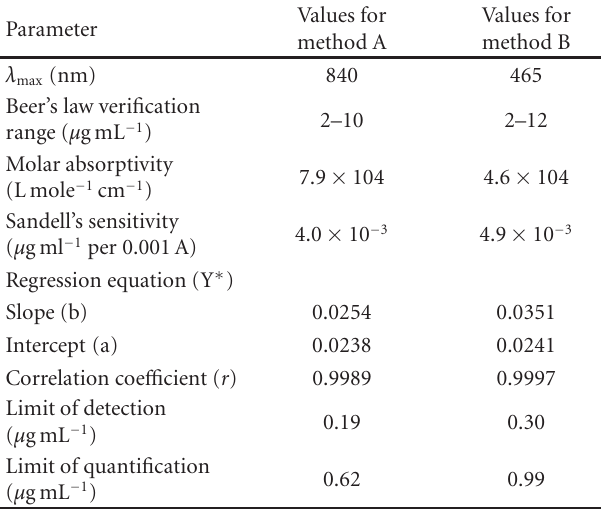
Table 1: Selected spectral data for the determination of alendronate sodium by proposed spectrophotometric